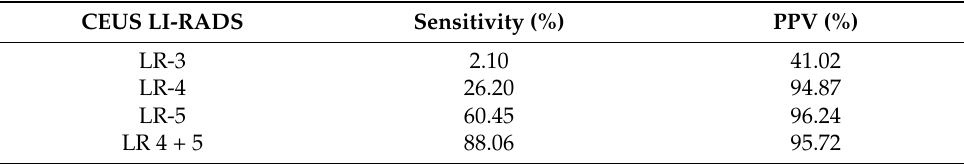
Table 7. Diagnostic accuracy of LR patterns for